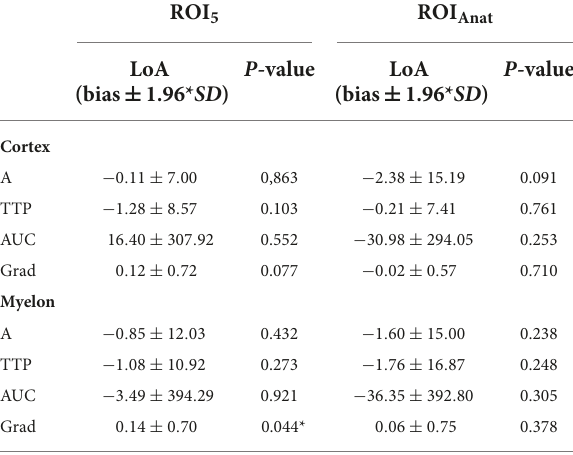
TABLE 9 Bland Altman statistics for ROI 5 and ROI Anat